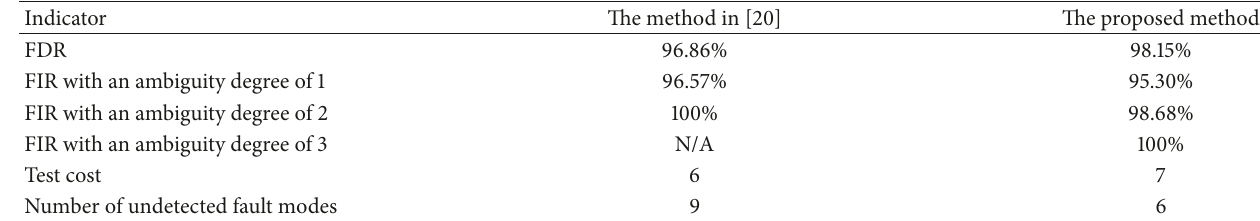
Figure 3: Comparison of the average convergence time of GA and ICDPSO. Table 3: The experimental results of different methods.